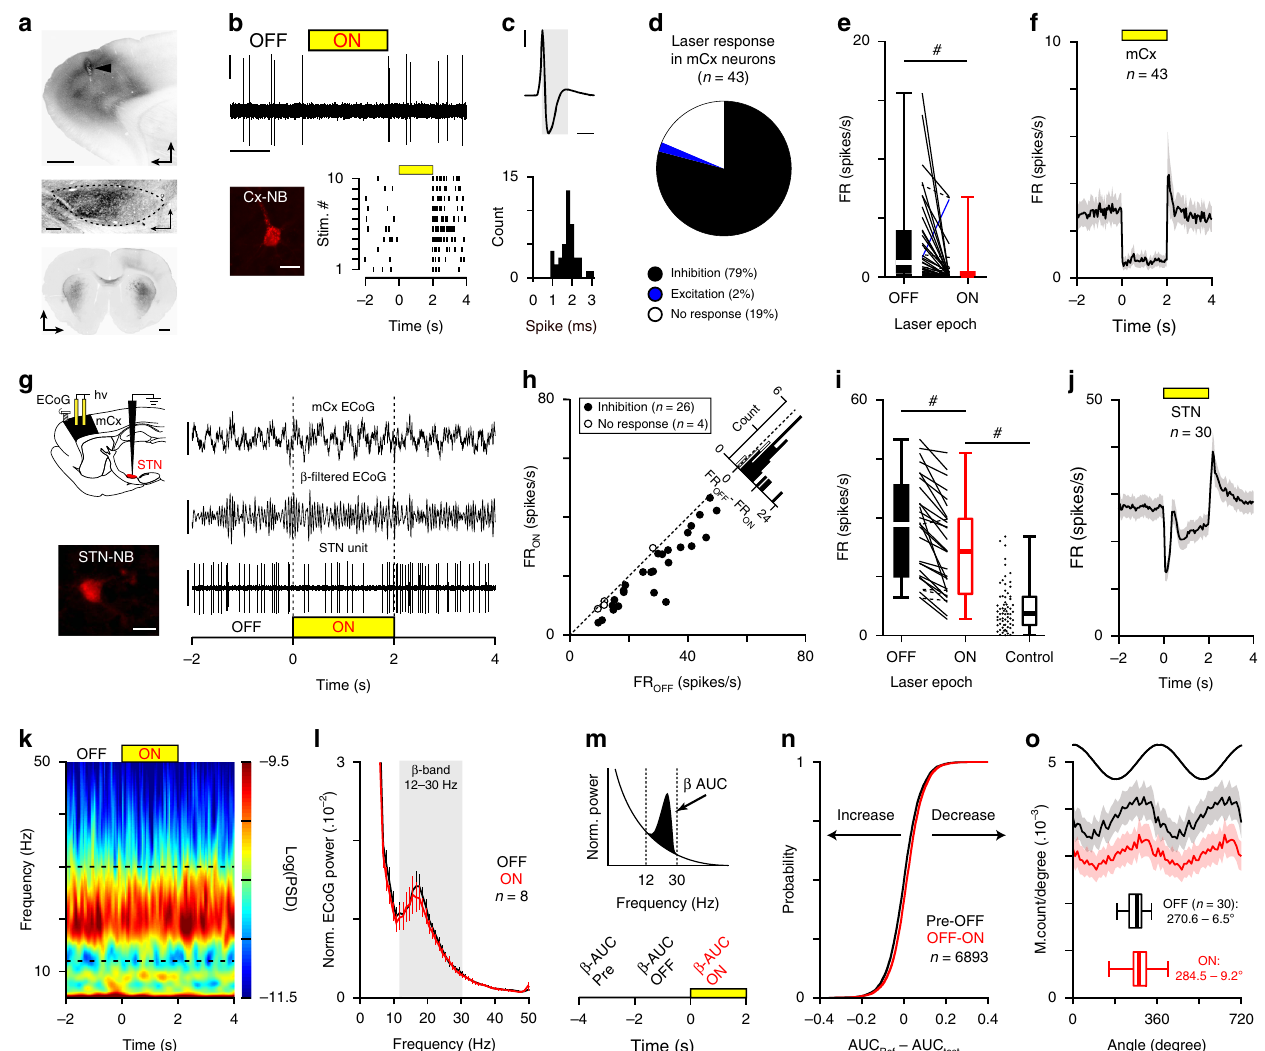
Fig. 1 Motor cortex activity is not necessary for abnormal network dynamics in cortico-BG loop. a Epi fl uorescent images showing eArchT3-EYFP labeling in mCx (top, scale: 1 mm), STN (middle, scale: 200 µ m), and striatum (bottom, scale: 1 mm) of 6-OHDA rats. Arrowhead indicates the optic fi ber track in mCx. b Opto-inhibition example of a pyramidal neuron (top, scales: 0.5 mV, 1 s) labeled with neurobiotin (bottom left, scale bar: 20 µ m) and corresponding raster plot (bottom right). c Example of action potentials waveform average (top, scales: 0.5 mV, 1 ms, same neuron as in b ) and spike duration distribution for mCx recorded neurons (bottom, bin: 0.2 ms). d Proportion of mCx neurons inhibited (black), excited (blue), or not modulated (white) by laser stimulation. e Box-and-whisker plots comparing mCx fi ring rate during OFF/ON laser epochs; fi ring rate (FR). f Population PSTH in mCx during laser stimulation (bin: 50 ms). g Experimental paradigm (top left) and representative example of ECoG (top right, scales: 100 µ V), β - fi ltered ECoG signal (12 – 30 Hz, middle right, scale: 50 µ V), and one STN unit (bottom right, scale: 2 mV) during mCx opto-inhibition. Juxtacellular neurobiotin labeling con fi rmed STN recordings (bottom left, scale: 20 µ m). h Scatter plots of STN neurons fi ring rate during ON versus OFF laser stimulation. i Box-and-whisker plots of STN fi ring during OFF/ON laser epochs in PD rats, and in control animals. j Population PSTH of STN fi ring during mCx opto-inhibition (bin: 50 ms). k Peri-event spectrogram of mCx ECoG recording during mCx opto-inhibition. l Mean normalized power spectrum of mCx ECoG during OFF versus ON laser epochs (analysis on the best β epochs for each rat). m Schematic of the β -AUCs calculation (top) that we performed at three consecutive time periods: ‘ Pre ’ , ‘ OFF ’ , and ‘ ON ’ laser stimulation (bottom) for every single opto-stimulation epoch. n Cumulative distribution function of the β -AUCs differences calculated between AUC (Pre-OFF) and AUC (OFF – ON) for every ECoG β epochs. o Mean phase histograms of STN neurons during β -oscillation for the OFF and ON laser epochs. Group data represents mean ± SEM, box-and-whisker plots indicate median, fi rst, third quartile, min, and max values. See also Supplementary Table 1 for statistical information. inhibition was veri fi ed for each animal using opto-electrode rhythm 24,25,35 . We tested the STN contribution to β -oscillations ’ mapping and the animals that did not reach satisfactory level of generation using an opto-inhibitory approach (Fig. 2a) based on STN inhibition (i.e., >60%) were excluded from further analysis two different viral constructs: either an AAV5-CaMKII-eArchT3 (see ‘ Methods ’ ). For both sets of experiments, STN neuronal fi ring rate was strongly reduced by light stimulation (Fig. 2d, e virus as performed in a seminal study 36 , or an AAV5-hSyn- eArch3. Qualitative (Fig. 2b, c) and quantitative (Supplementary and Supplementary Table 2). We next tested the impact of STN Fig. 3a, b) histological control of EYFP expression con fi rms the opto-inhibition on the expression of β -oscillations (best β -power transduction of STN neurons. The ef fi cacy of STN opto- recordings for each rat). We found that the β power (Fig. 2f and NATURE COMMUNICATIONS|